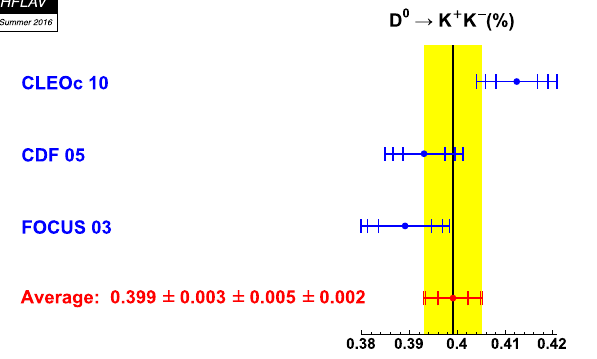
Fig. 212 The B ( D 0 → K + K − ) ( left ) and B ( D 0 → π + π − ) (right) values obtained by scaling the measured branching ratios with the B ( D 0 → K − π + ) branching fraction average obtained here. For the measurements ( blue points ), the error bars correspond to the statistical,